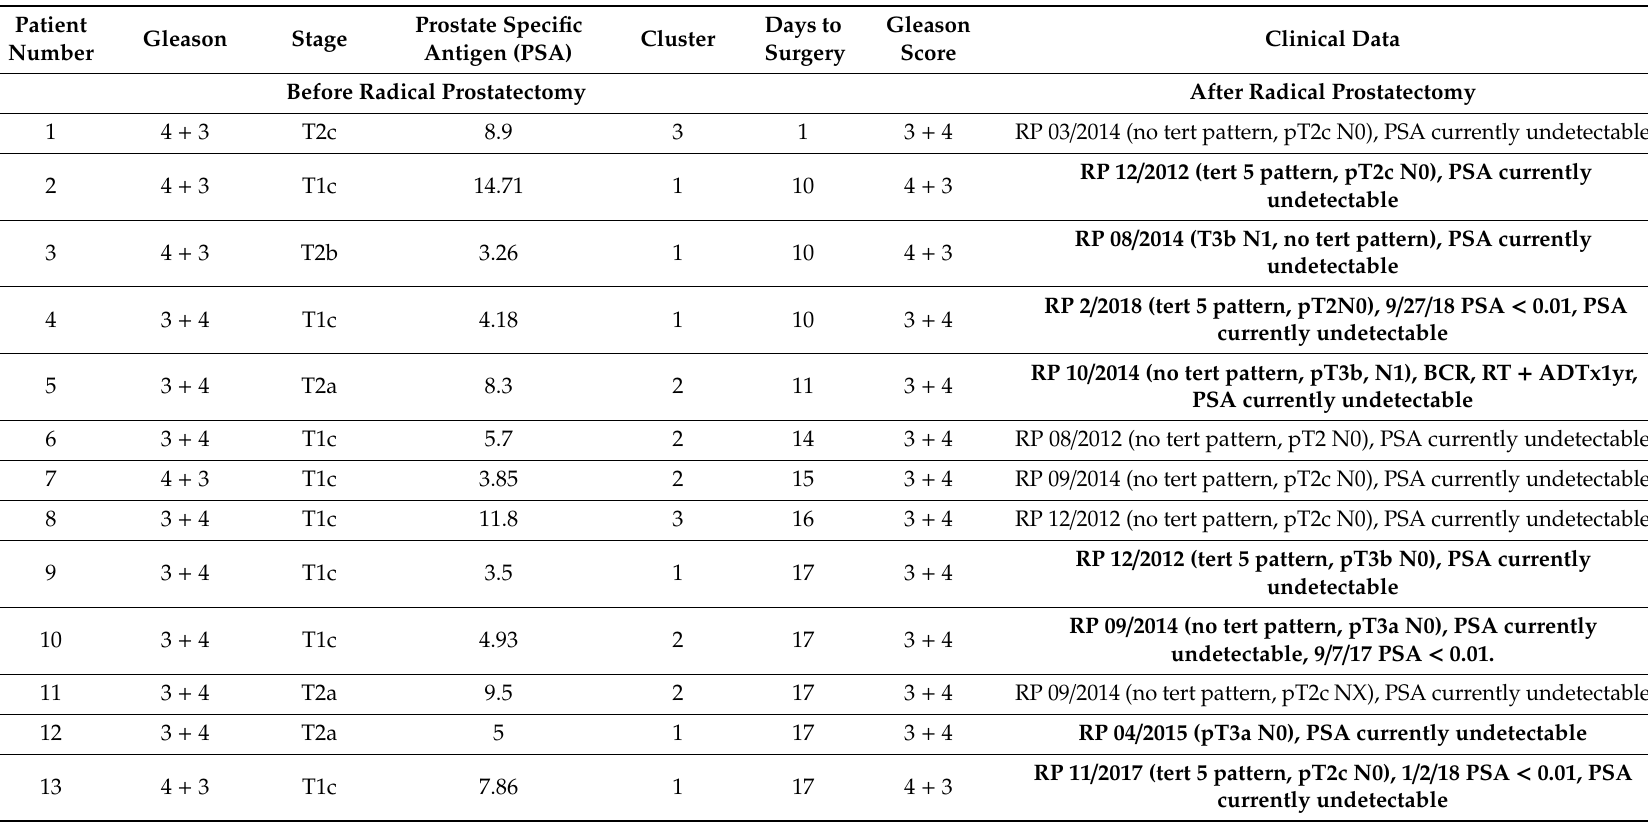
Table 1. Clinical information of 65 intermediate risk prostate cancer patients at biopsy and after radical prostatectomy. Bold highlights patients whose cancer was upgraded after radical prostatectomy (RP). Days to surgery after circulating tumor cells (CTC) collection varied among patients. The results of the hierarchical centroid cluster analysis (Figure 1) are indicated for each patient (clusters 1, 2 or